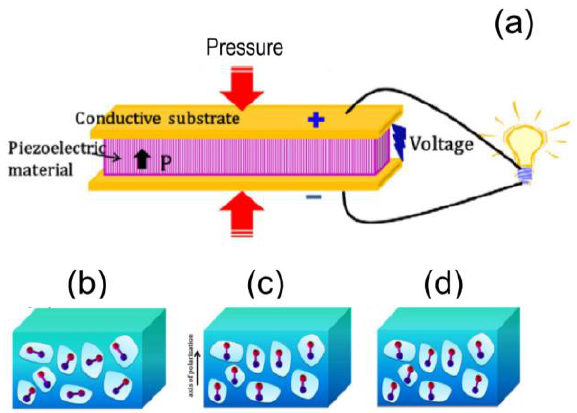
Figure 31. ( a ) Piezoelectric nanogenerator (PENG) and ( b – d ) its working principle. ( b ) Non-centrosymmetric crystal structure of piezoelectric materials. ( c – d ) Distortion of the crystal structure under mechanical load and generation of piezoelectric potential due to the charge separation process (reproduced from reference [251] with permission. Copyright 2018, Elsevier).